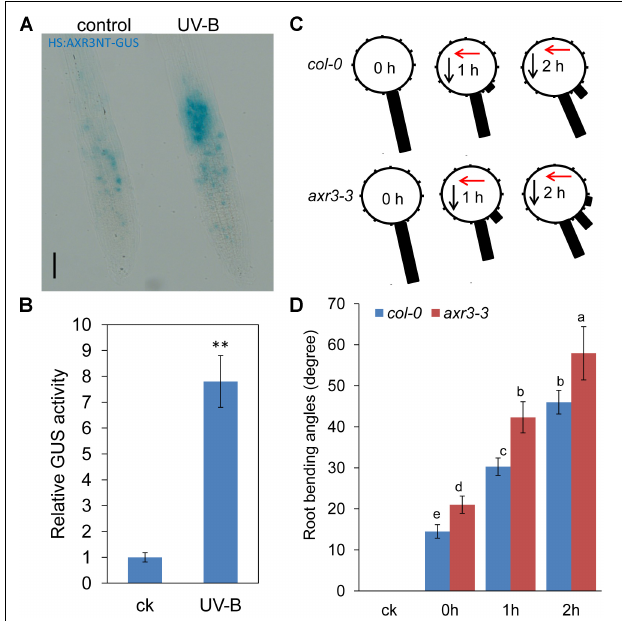
FIGURE 3 | UV-B radiation increases the stabilization of Aux/IAA. (A) Image of GUS-staining of the roots of 5-d-old HS:AXR3NT-GUS seedlings. Seedlings were heat shocked at 37 ◦ C for 2 h, treated with or without UV-B radiation for 1 h, and then transferred to normal growth conditions for 45 min at 23 ◦ C, followed by GUS staining. Bars, 60 µ m. (B) Relative GUS activity of HS:AXR3NT-GUS , as treated in (A) . The error bars represent the SE. Asterisks ( ∗∗ ) indicate significant differences with respect to the corresponding control ( P < 0.01 by Tukey’s test). (C,D) The angle of root bending of Col-0 and axr3-3 seedlings irradiated with UV-B for 1 h and then transferred to normal growth conditions for 0–2 h; ck, before UV-B radiation control. Col-0 , n = 60; axr3-3 , n = 60. (C) Each gravistimulated root was assigned to 1 of the 12 30 ◦ sectors on a gravitropism diagram. The length of each bar represents the mean percentage of seedlings assigned to the respective sector. The red and black arrows indicate the direction of UV-B radiation and gravity, respectively. (D) The average root bending angles of Col-0 and axr3-3 seedlings. The error bars represent the ± SE, and different letters indicate significantly different values ( P < 0.01 by Tukey’s